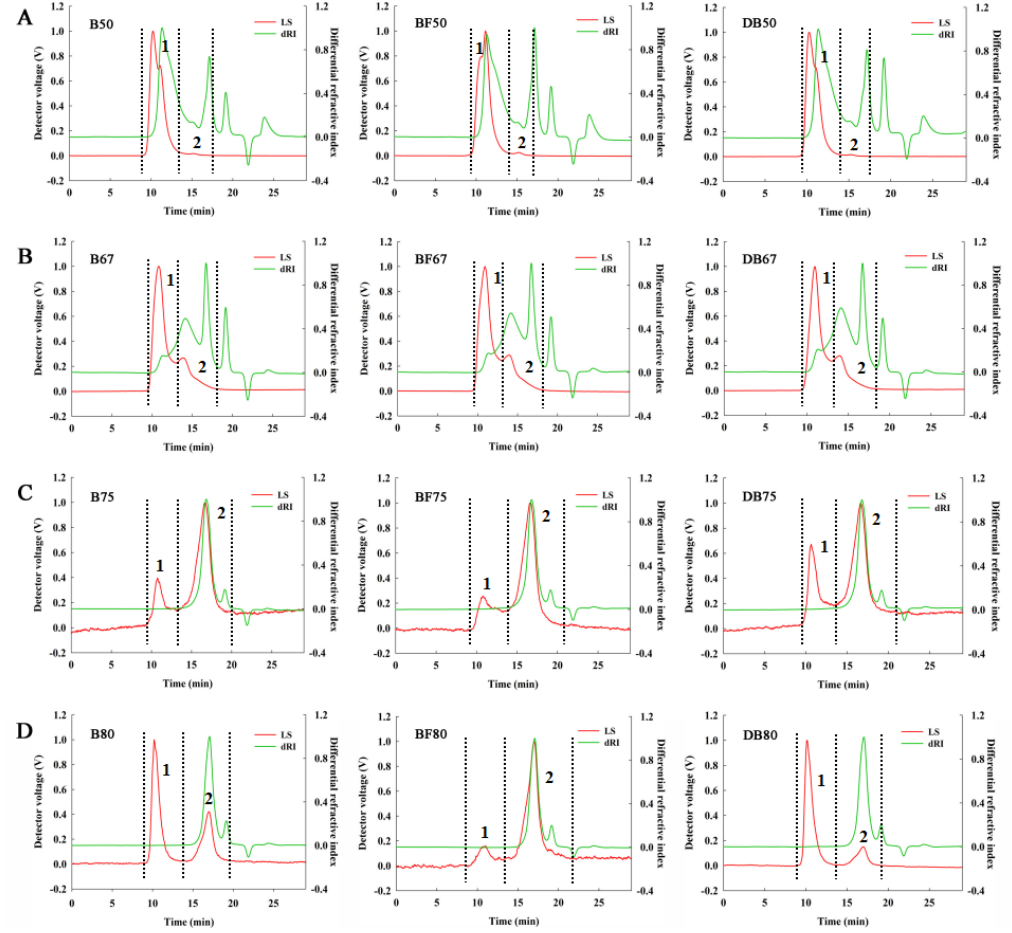
Figure 2. Distribution of molecular weight of arabinoxylan.